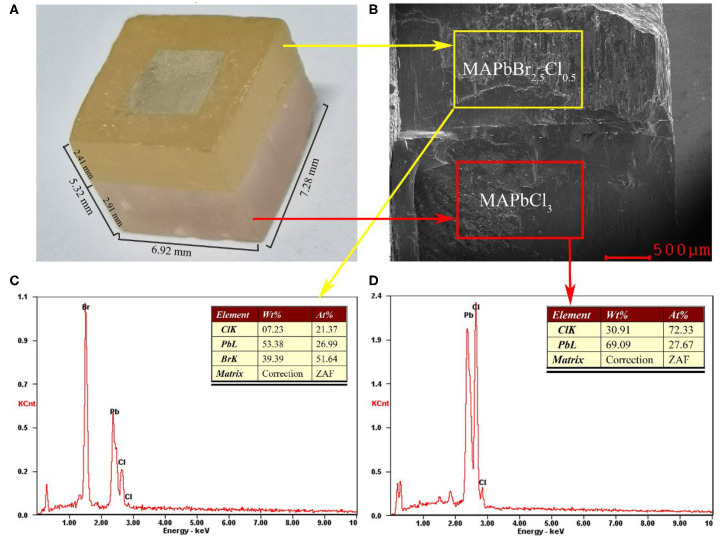
(A) Optical image of the epitaxial PIN device. (B) Cross-sectional SEM images of the double-layer perovskite bulk. EDX spectra of (C) epitaxial MAPbBr2.5Cl0.5 perovskite layer and (D) MAPbCl3 perovskite layer.